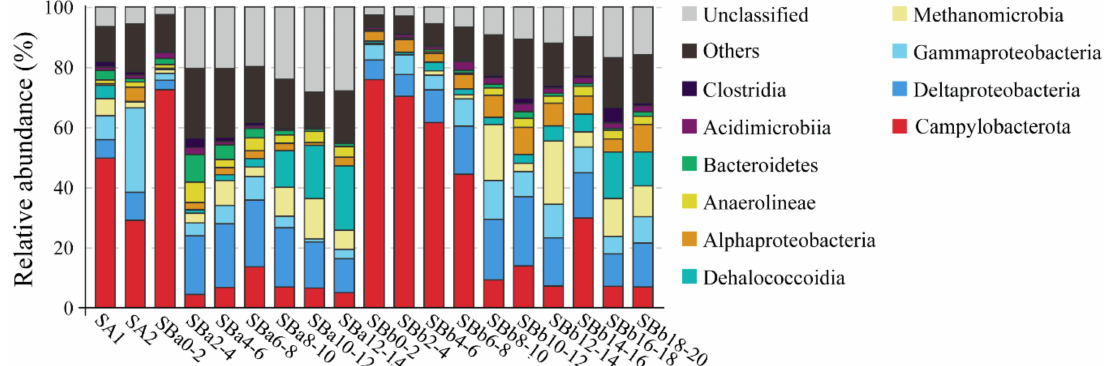
Figure 4. The diversity and distribution of microbial sequence tags in the libraries of sediment samples. SA1 and SA2 represent the libraries of the sediments covered with the animal community; SBa and SBb represent the libraries of the sediments away from the center, with the numbers after SBa and SBb indicating the depth (cm). The sequence tags were generated with the next-generation sequencing (NGS) platform and classified at the phylum / class level. Each color represents the percentage of the taxon in the total assemblage. The top 10 groups in each sample are labeled, and other groups are integrated as “Others”.